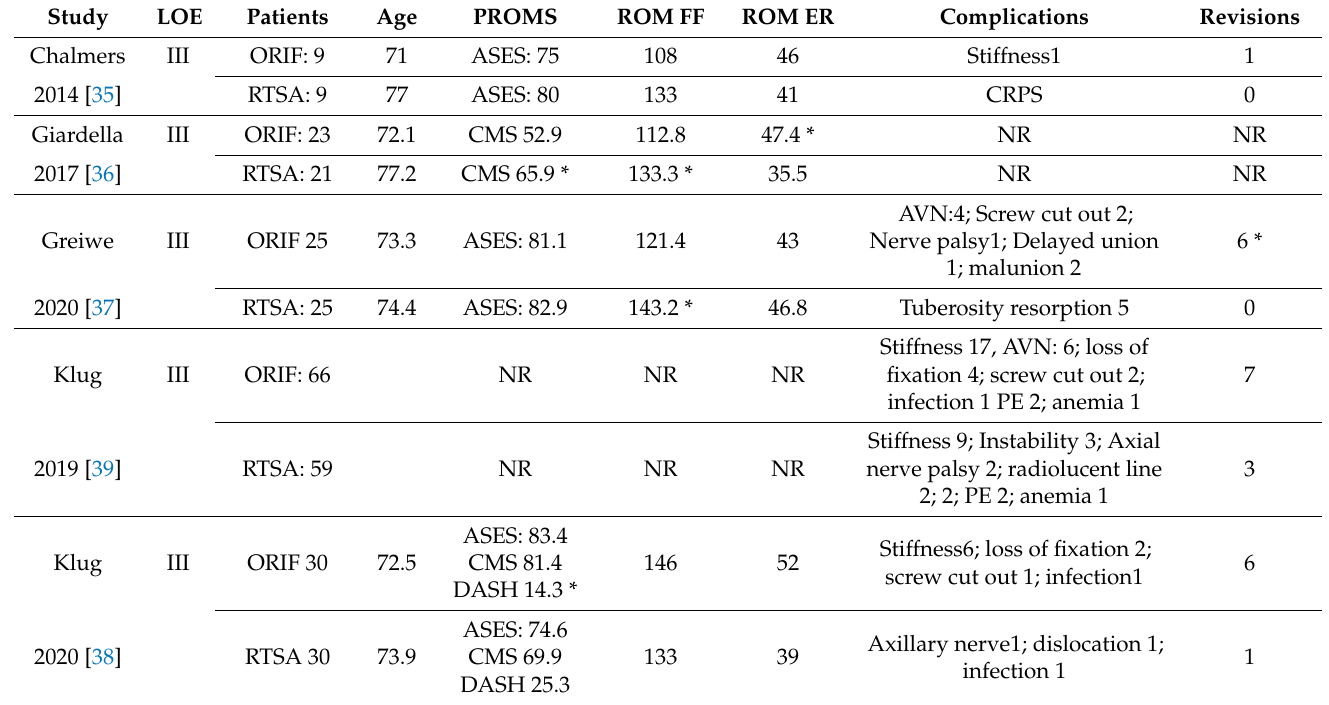
Table 2. Studies comparing RTSA vs. ORIF for the treatment of proximal humerus